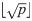
Error rate estimates for the binary power case study (unbalanced).Shown are different error rate estimates for the setting with two response classes of unequal size (smaller class containing 30% of the observations) and with both predictors with effect and without effect. The error rate was estimated through the test error, the OOB error, the stratified OOB error, the CV error, and the stratified CV error for settings with different sample sizes, n, and numbers of predictors, p. The mean error rate over 500 repetitions was obtained for a range of mtry values. The vertical grey dashed line in each plot indicates the most commonly used default choice for mtry in classification tasks, that is ⌊p⌋.